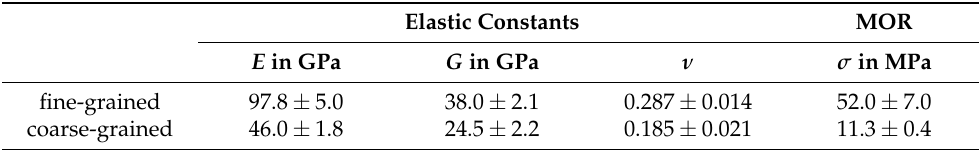
Table 7. Determined values of the elastic constants Young’s modulus E , shear modulus G and Poisson’s ratio ν and the four-point bending strength σ of the sintered fine-grained and coarse- grained composites given as mean value ± standard deviation.